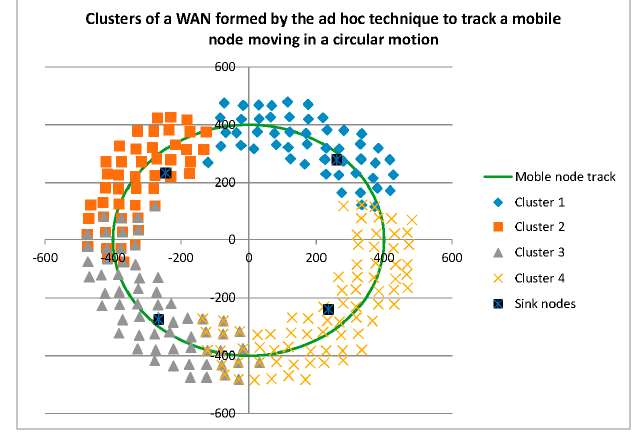
Figure 3. Clusters formed by the Ad Hoc technique.